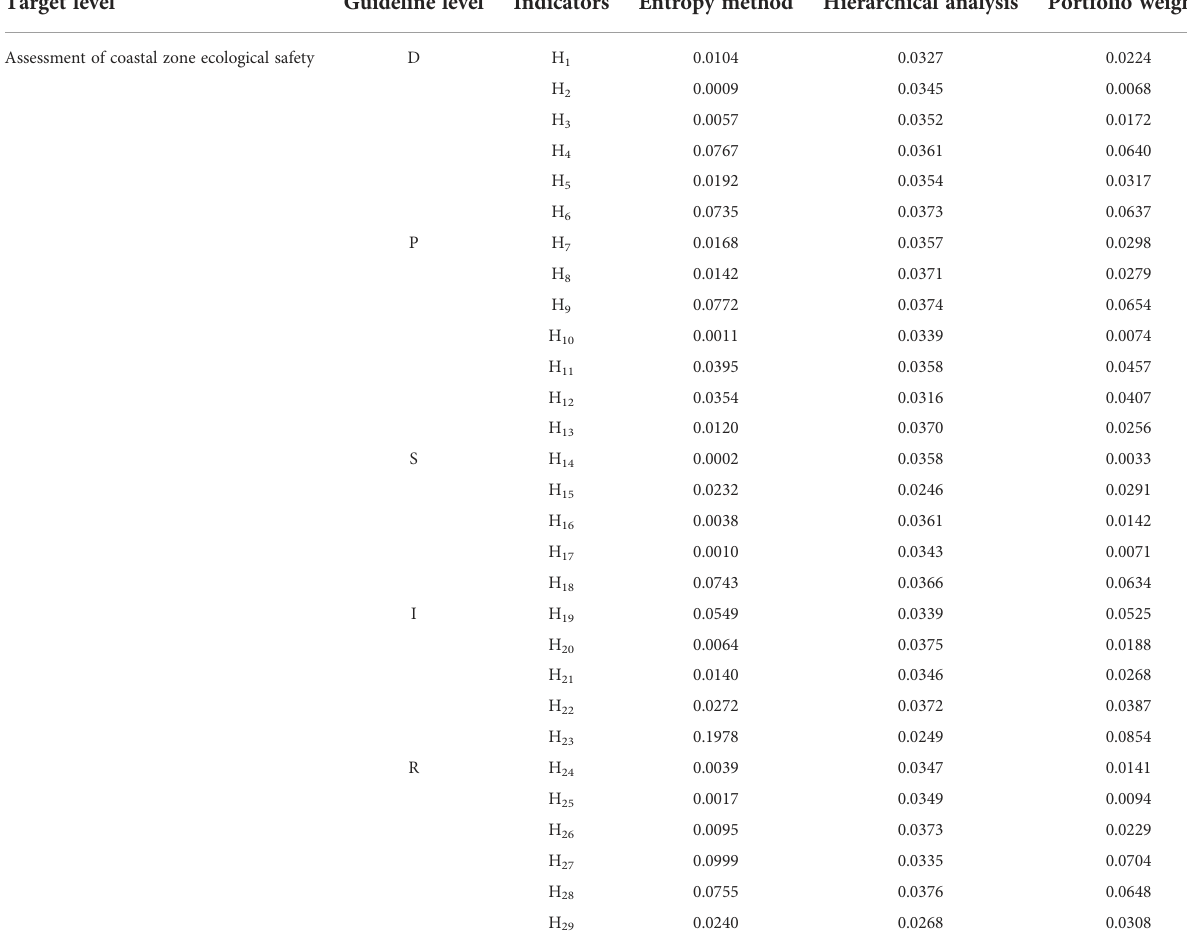
TABLE 4 Weight evaluation indicators of coastal ecological security in Qinzhou